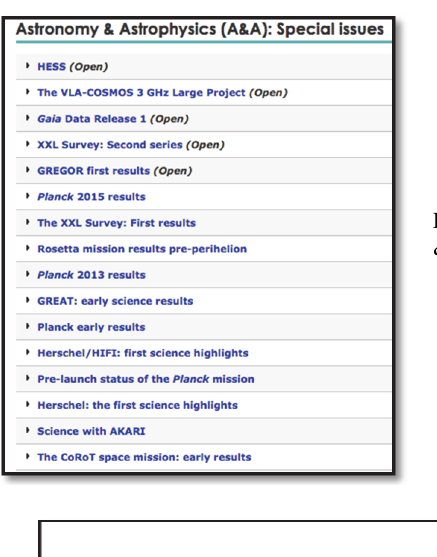
Figure 1. Some of the special issues published by Astronomy